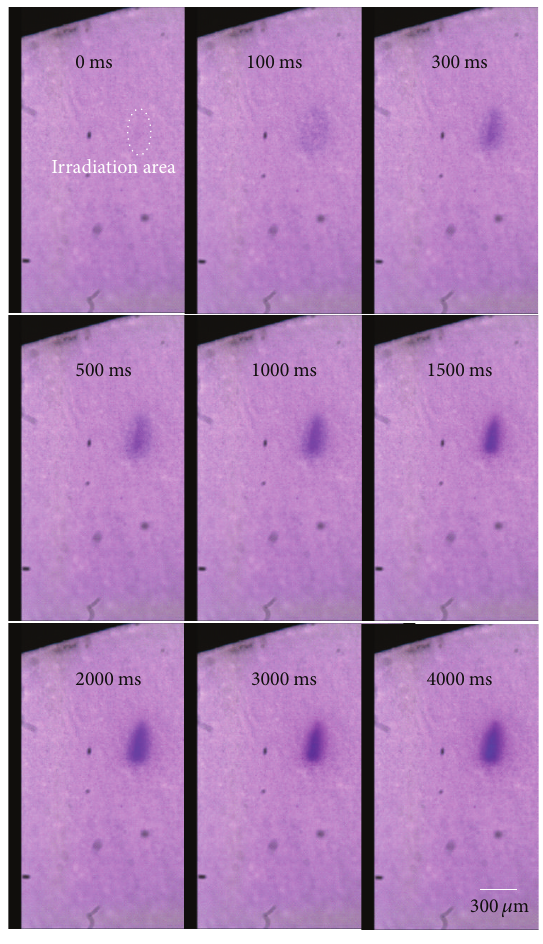
Figure 5: Photographs showing visualization for the synchrotron radiation of SPring-8 using the SP/BaFCl:Eu 2+ PC composite film. Deep purple areas indicate the spot that is irradiated with the synchrotron radiation of